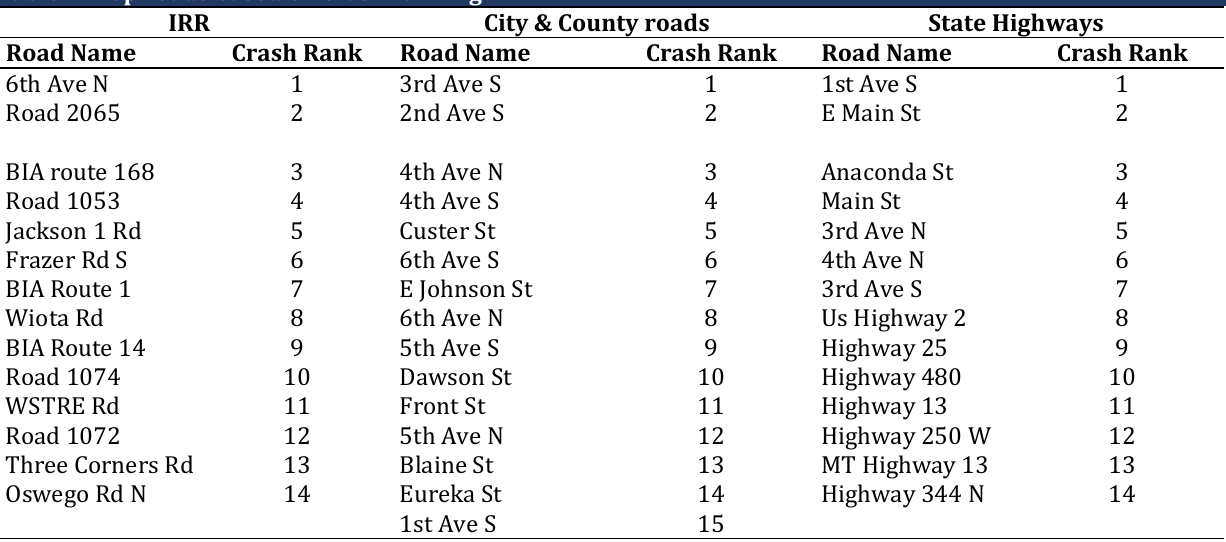
Table 1: Top roads based on crash